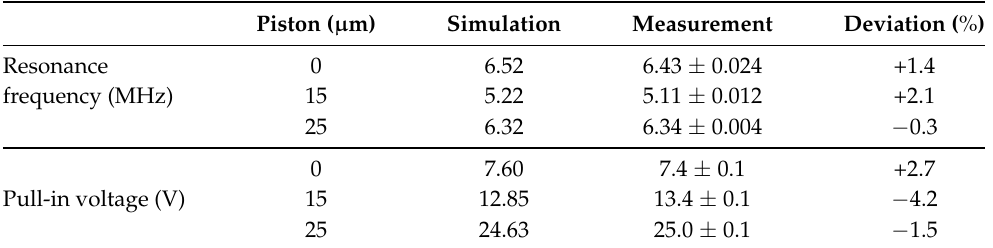
Table 3. Comparison of resonance frequency and pull-in voltage in simulation and